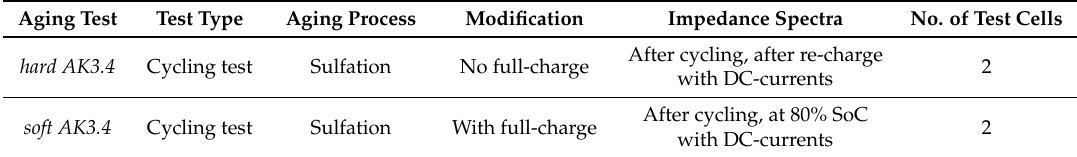
Table 1. An overview of the performed aging tests, with information about the tests, the performed impedance spectra, and the used test